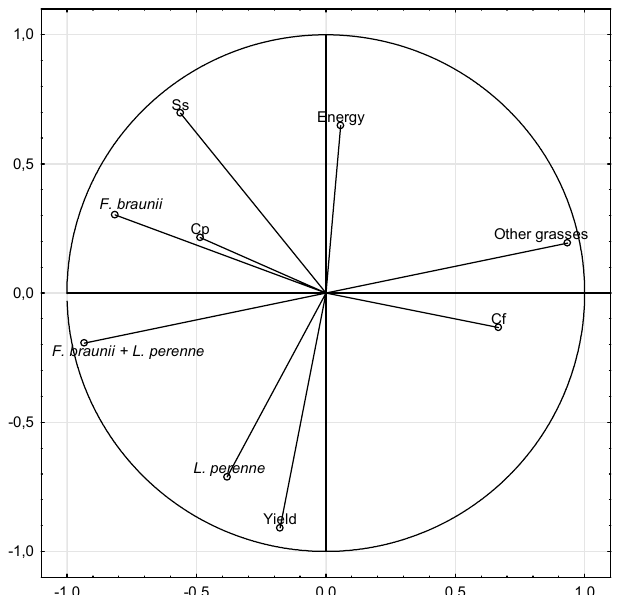
Figure 3. The principle component analysis (PCA) for Lolium perenne , Festulolium braunii , F. braunii + L. perenne, Other grasses abundance and forage value of sward. F. braunii—abundance in the sward, L. perenne , Other grasses abundance and forage value of sward. F. braunii —abundance in the sward, L.